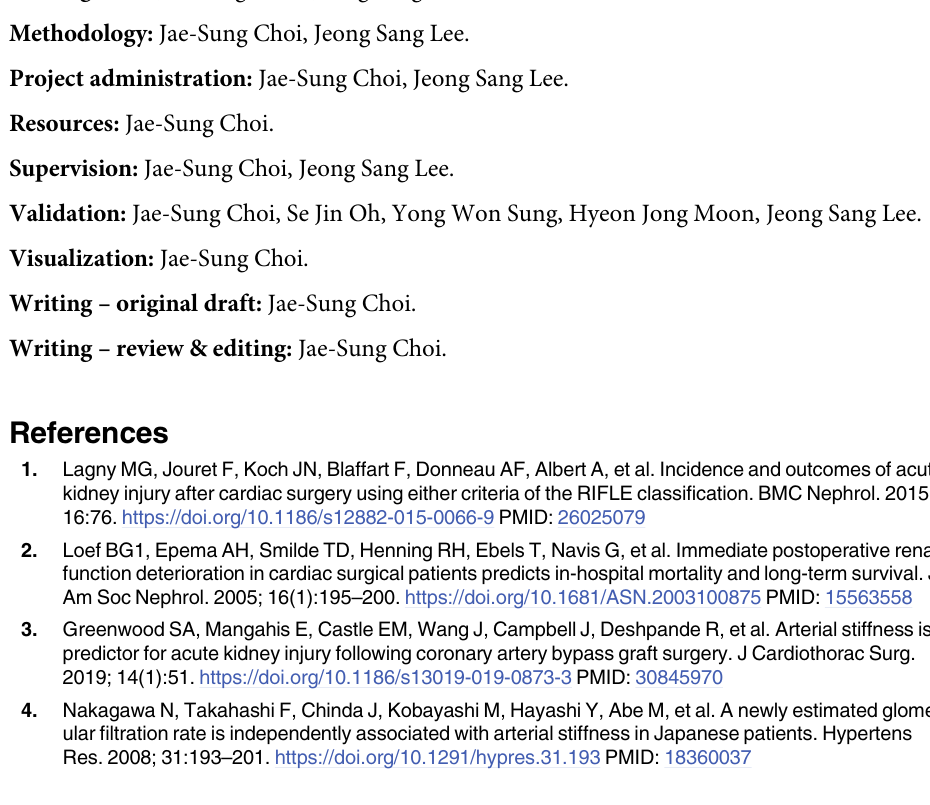
S1 Table. Baseline clinical characteristics of low baPWV and high baPWV